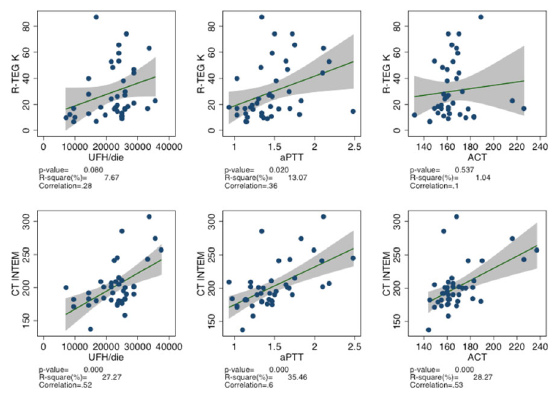
Fig. 1 (abstract 000925). Correlation between CT INTEM / R-TEG K and UFH infusion, aPTT and